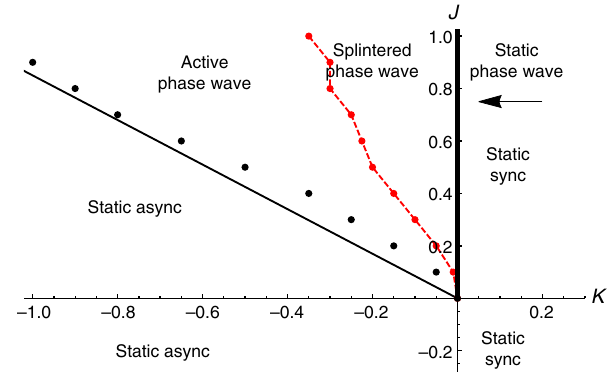
Fig. 1 Phase diagram. Locations of states of the model de fi ned by Eqs. (3) and (4) with A = B = 1 and v i = ω i = 0 in the ( J , K ) plane. The straight line separating the static async and active phase wave states is a semi-analytic approximation given by (18). Black dots show simulation data. These were calculated by fi nding where the order parameter S bifurcates from zero, de fi ned by where its second derivative with respect to K is largest. Similarly, the red dots separating the active phase wave and splintered phase wave states were found by fi nding where the order parameter γ bifurcates from 0. The red dashed line simply connects these points and was included to make the boundary